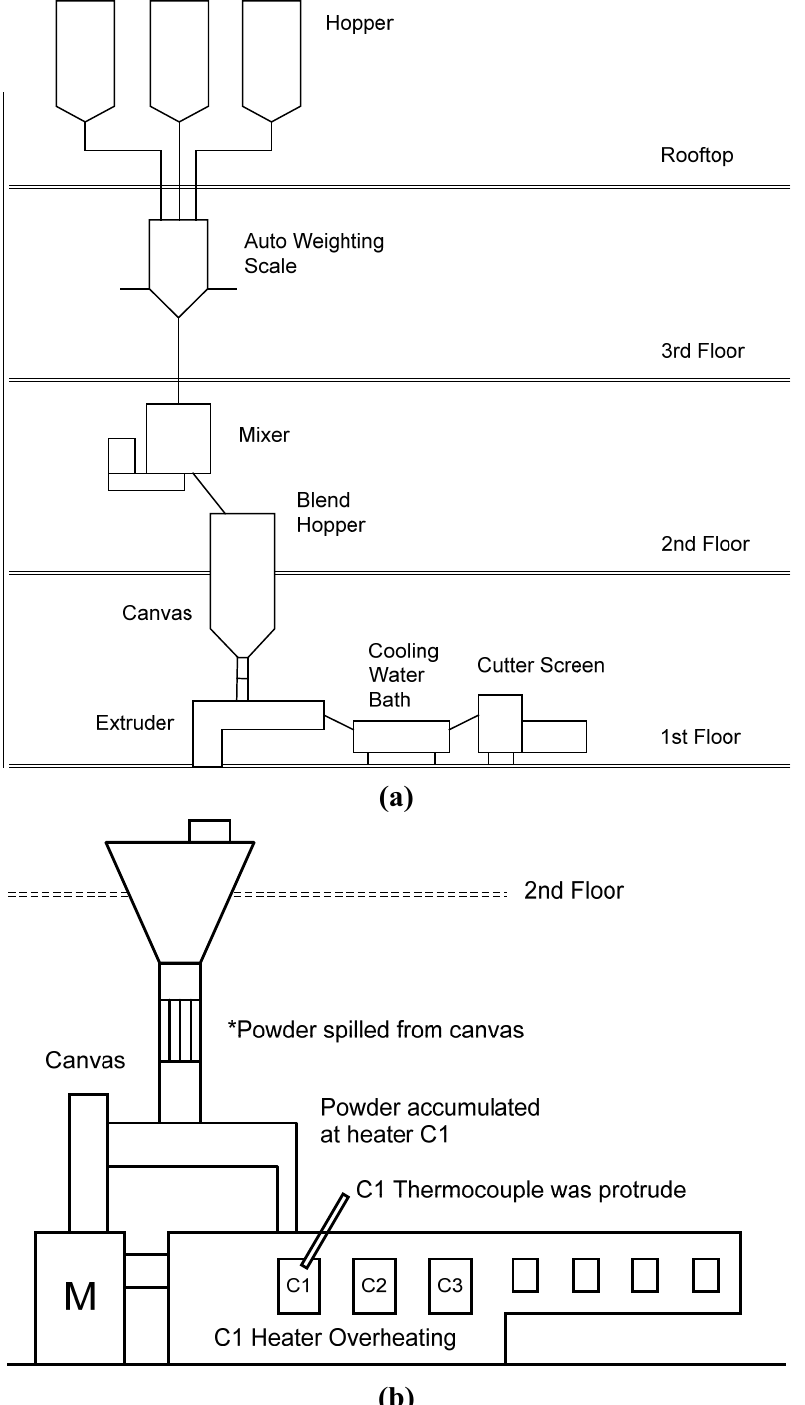
Figure 5. Layout of the compounding plant. (a) The simplified layout of the whole plant; (b) The layout of the compounding